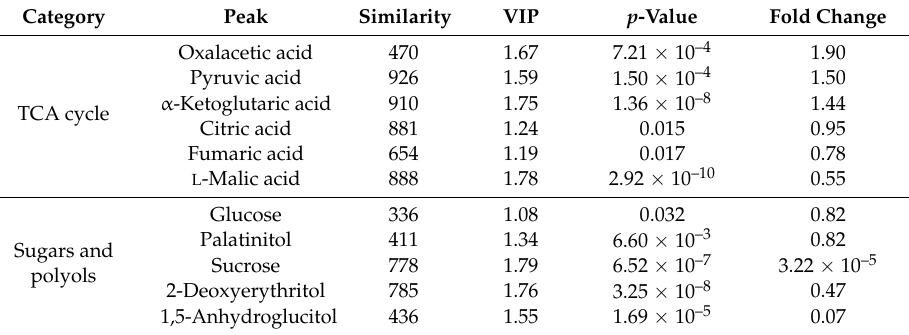
Table 2. Major metabolite changes in WBPH under cold stress. By GC-TOF-MS analyses of six biological replicates of cold-stressed and unstressed virus-free WBPH, the metabolites that had a VIP > 1.0 and p -value < 0.05 were considered to be significantly altered metabolites, and the metabolites involved in TCA cycle, sugars, and polyols were selected to show in the table.